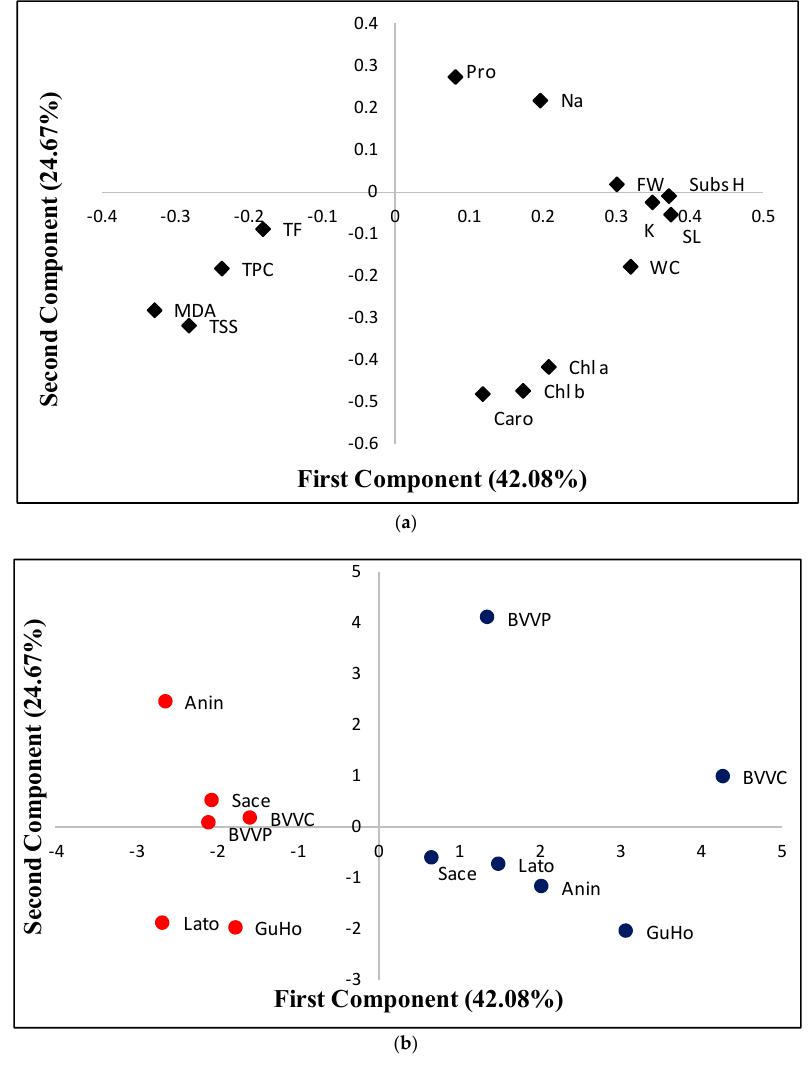
Figure 8. Loading ( a ) and score ( b ) plots for a principal component analysis (PCA) based on the first and second component, which respectively account for 42.08% and 24.67% of the total variability observed in six Romanian provenances of L. decidua from control plants (blue dots) or submitted to drought stress(red dots) after one month of initiation of the treatments. Subs H, substrate humidity; SL, stem length; FW, fresh weight; WC, water content; Pro, proline; TSS, total soluble sugars; Na, sodium; Chl a, chlorohyll a; chl b, chlorohyll b; caro, carotenoids; MDA, malondialdehyde; TPC, total phenolic compounds; TF, total flavonoids.